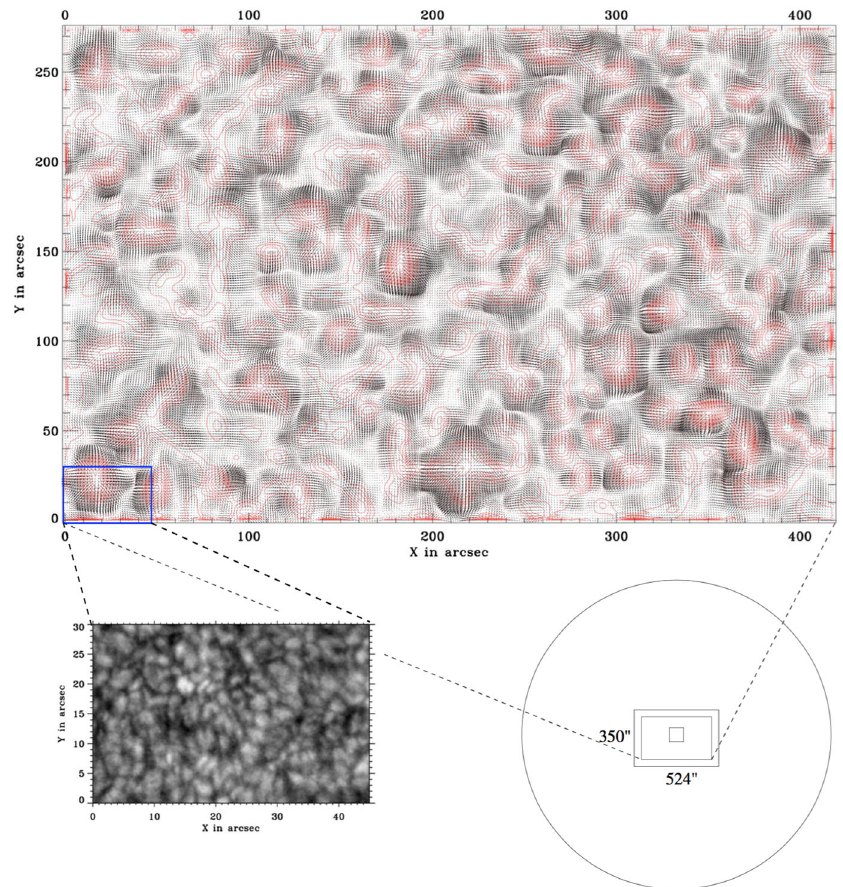
Fig. 3 The supergranulation horizontal velocity field as obtained by granule tracking. Image reproduced with permission from Rieutord et al. (2008), copyright by